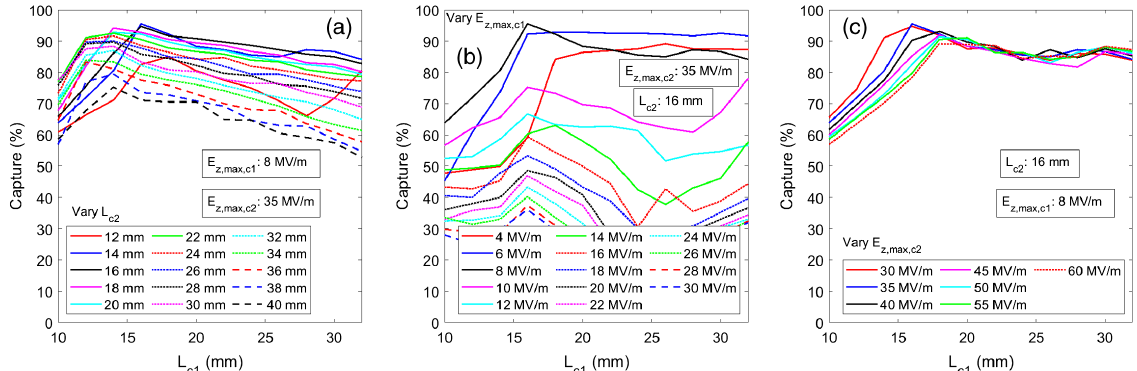
FIG. 4. 1D code coarse scan